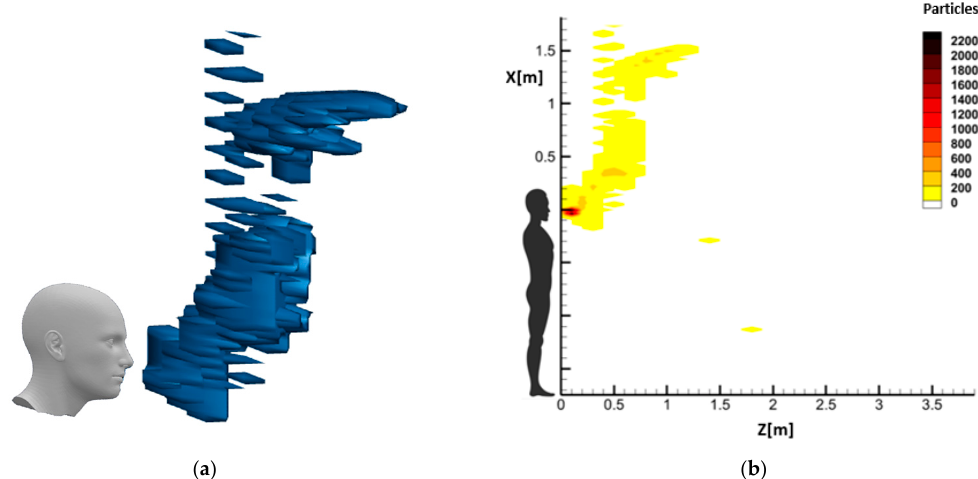
Figure 7. The accumulated number of droplets in case of a cough after 80 s: ( a ) Iso-surface representation, ( b ) 2D contour plot.